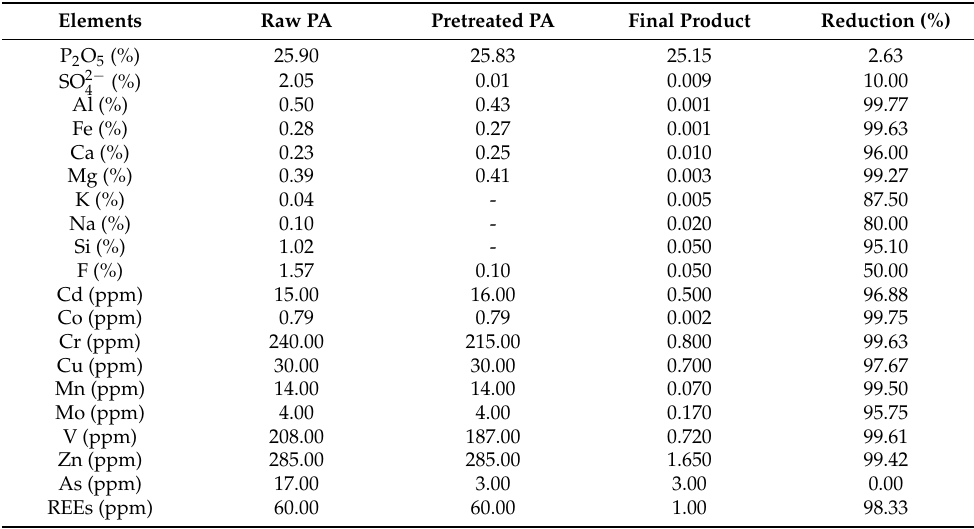
Table 4. Elemental content of nanofiltrated PA at the industrial pilot scale